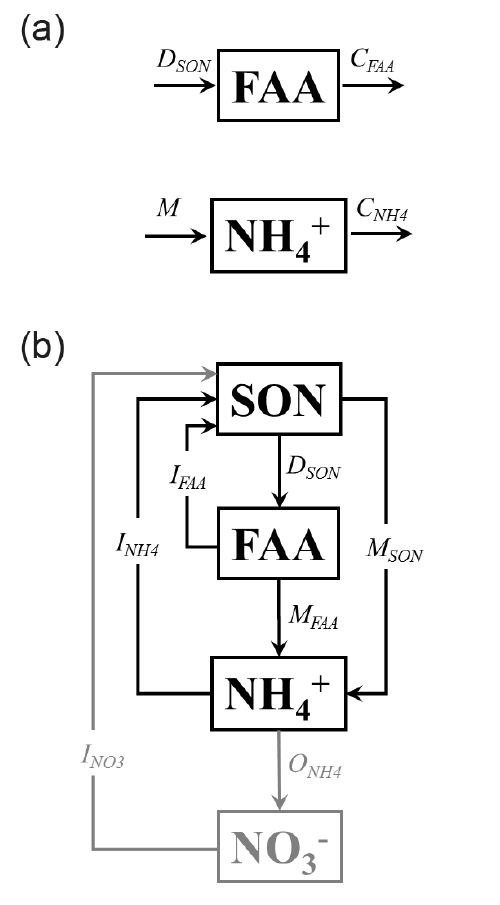
Figure 1. (a) Schematic analytical model: gross N mineral- ization ( M ); ammonium consumption ( C NH sumption ( C FAA ) and peptide depolymerization rate ( D SON